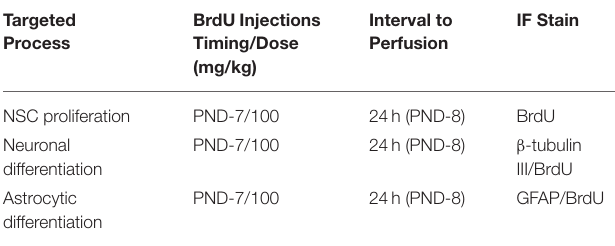
TABLE 1 | Experimental protocol. Targeted Process